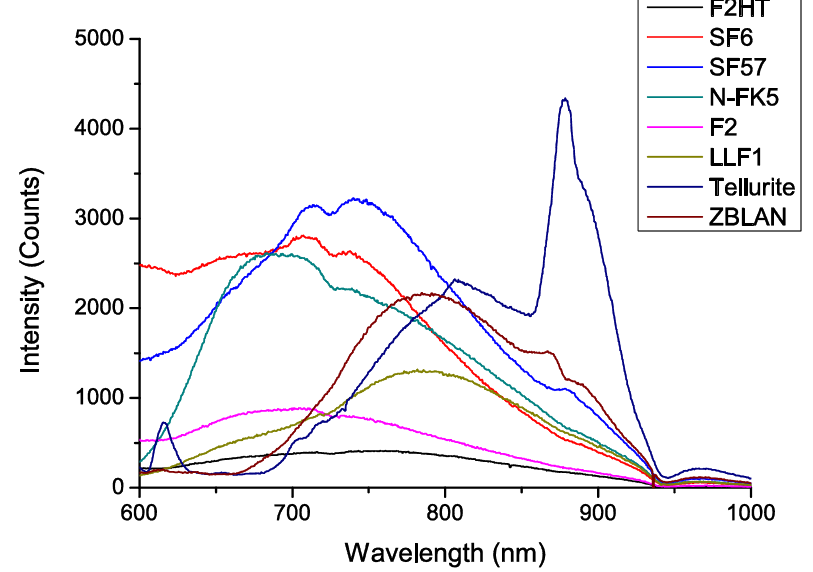
Figure 1. Bulk glass fluorescence measurements with 532 nm